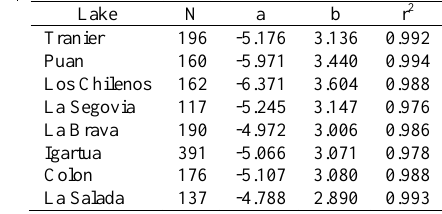
Table 2. Estimated parameters of the weight-length- relationships for the studied lakes. N: number of sampled fish; a: intercept; b: regression coefficient; r: correlation coefficient.